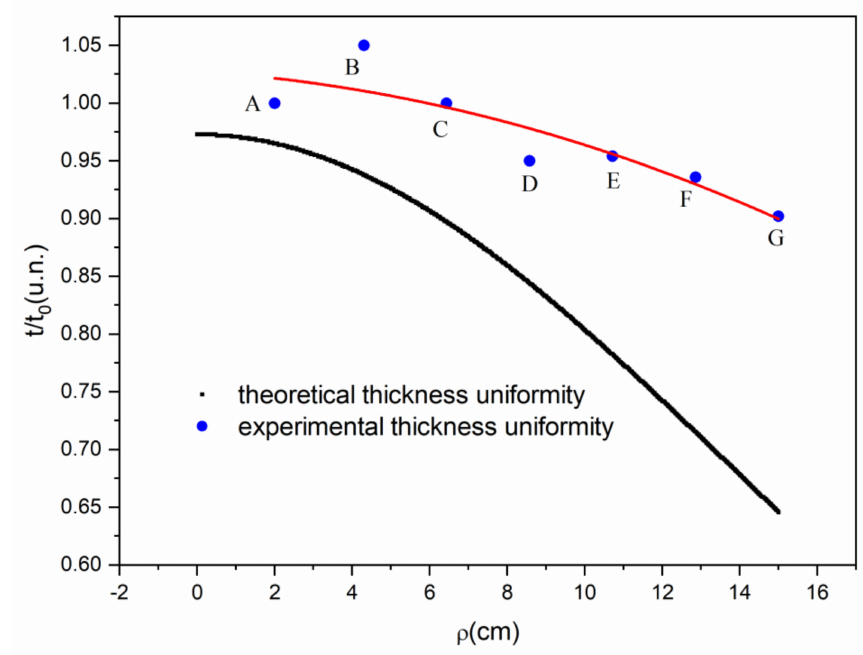
Figure 5. Distribution of the uniformity of the thickness of thin films in evaporation with